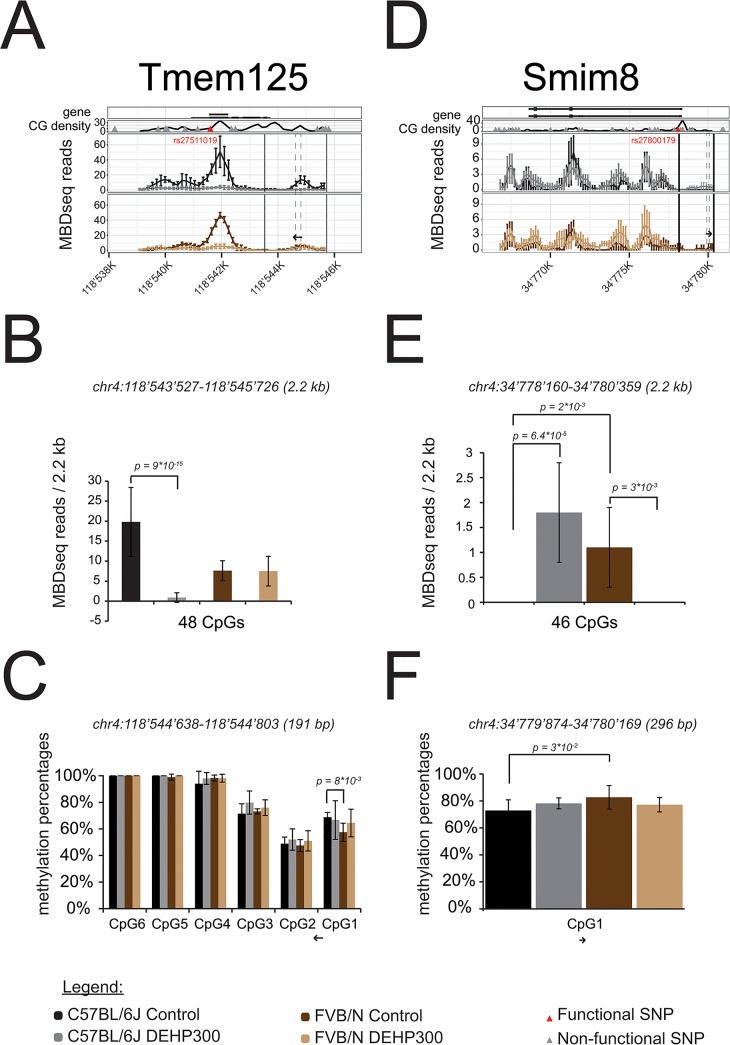
Confirmatory bisulfite pyrosequencing experiment in Tmem125 & Smim8.
(A, B, C) Images related with Tmem125. (D, E, F) Images related with Smim8. (A, D) Full scan derived from MBDseq data reflecting methylation levels in the entire genes and with the promoter regions as defined in the manuscript for the four tested conditions. The densities of CpG throughout the entire gene are shown as well as SNP between strains. The legend is located at the bottom of Fig 5 and the colors encoding the four conditions are respected all over the Fig 5. (B, E) Promoter methylation according to MBDseq experiments probing 2.2 kb promoters delimited and localized with vertical lines on the full scan in (A) and (D). (C, F) Promoter methylation according to pyrosequencing experiments probing the regions defined by dashed line on the full scan shown in (A) and (D) with an arrow indicating the sense of the pyrosequencing experiment. P-values resulting from T-Tests performed between conditions smaller than 0.05 and coordinates of the probed regions according to the mm10 mouse genome are shown (B, E, C, F).